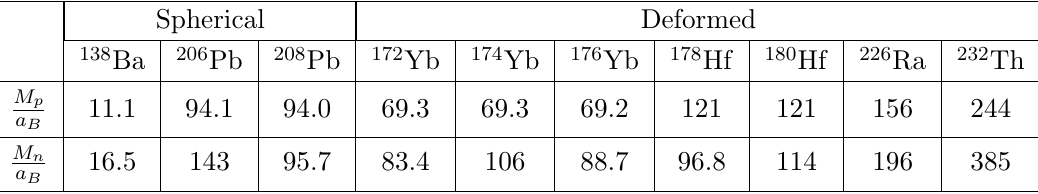
Table 5 . Numerical values for the electronic matrix elements M p and M n for several atoms of in-